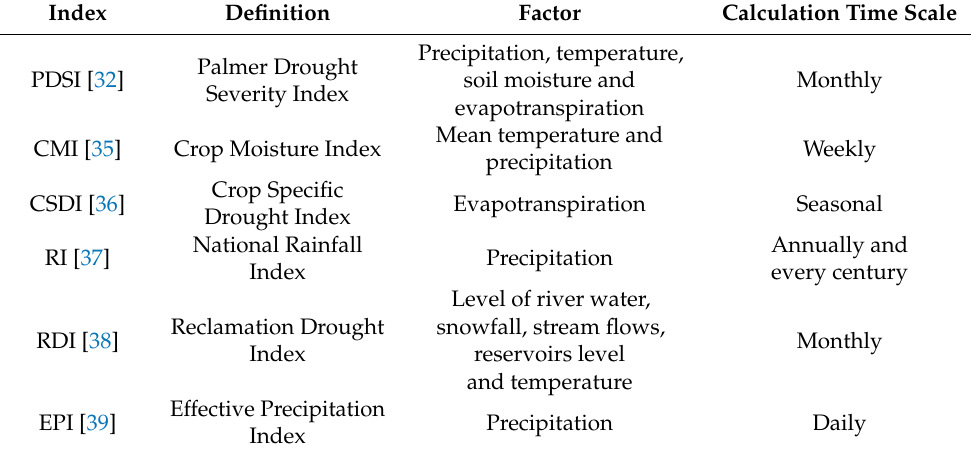
Table 1. Common drought